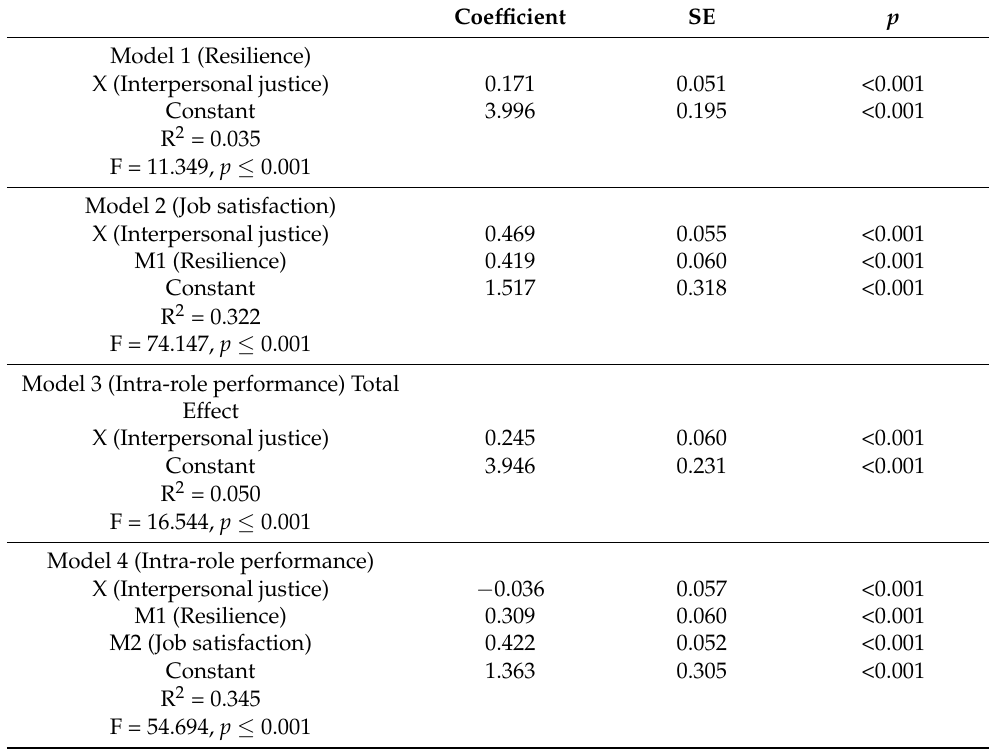
Table 2. Results from regression analyzes examining the mediator model of resilience (M1) and job satisfaction (M2) in the effect of interpersonal justice on intra-role performance.